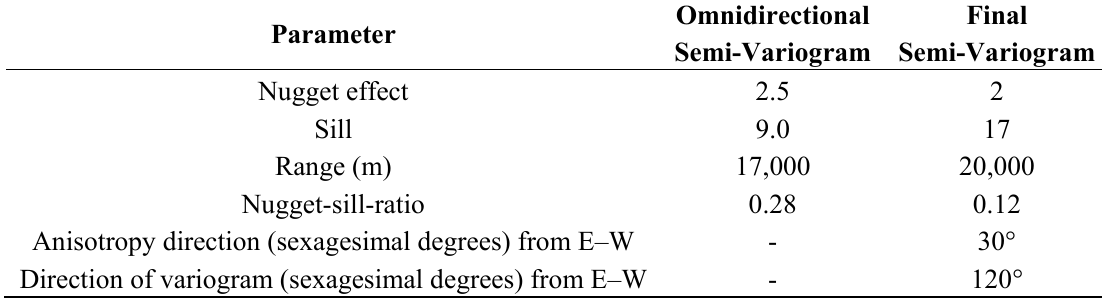
Figure 8. Final semi-variogram of the LDG sampled points. Table 3. Key parameters of Gaussian semi-variogram models.